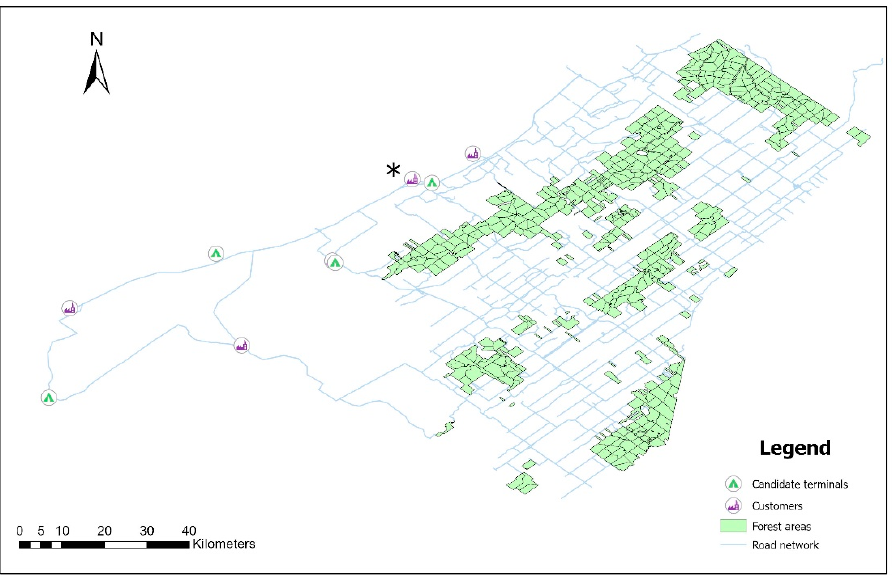
Figure 2. Case study area map showing the forest supply regions, candidate terminal locations, location of customers’ facilities and the road network. * represents the terminal selected using the proposed framework